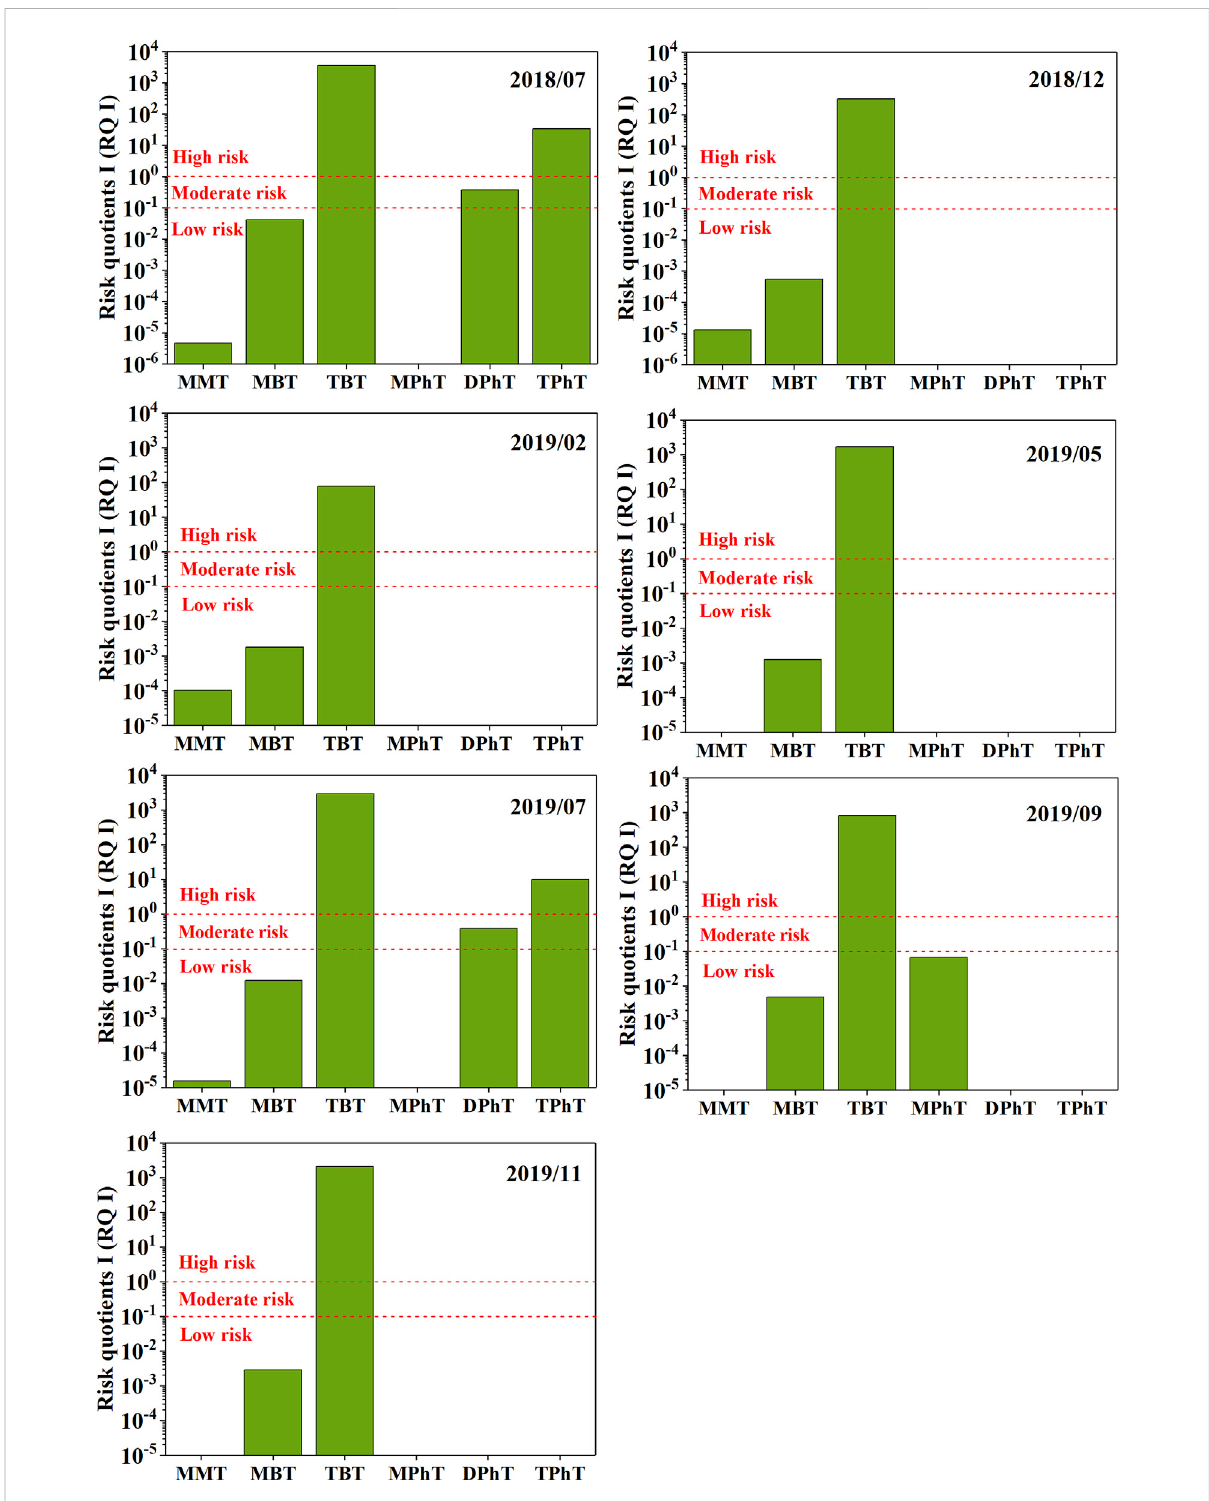
FIGURE 5 RiskquotientI(RQI)fortheecological riskassessmentoforganotincompounds(OTCs)inthedrinkingwater sourceintheupperYangtzeRiver